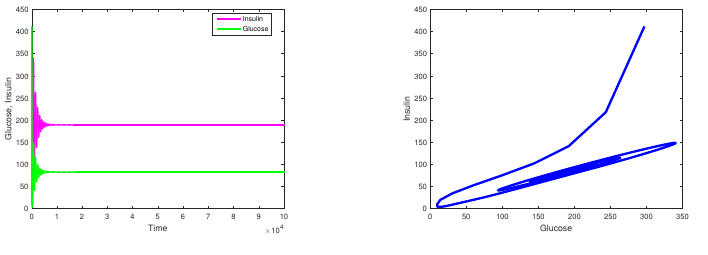
Figure 10. Glucose-insulin dynamics: dynamics and phase plain for τ g = 200 < τ ∗ g = 249 min.